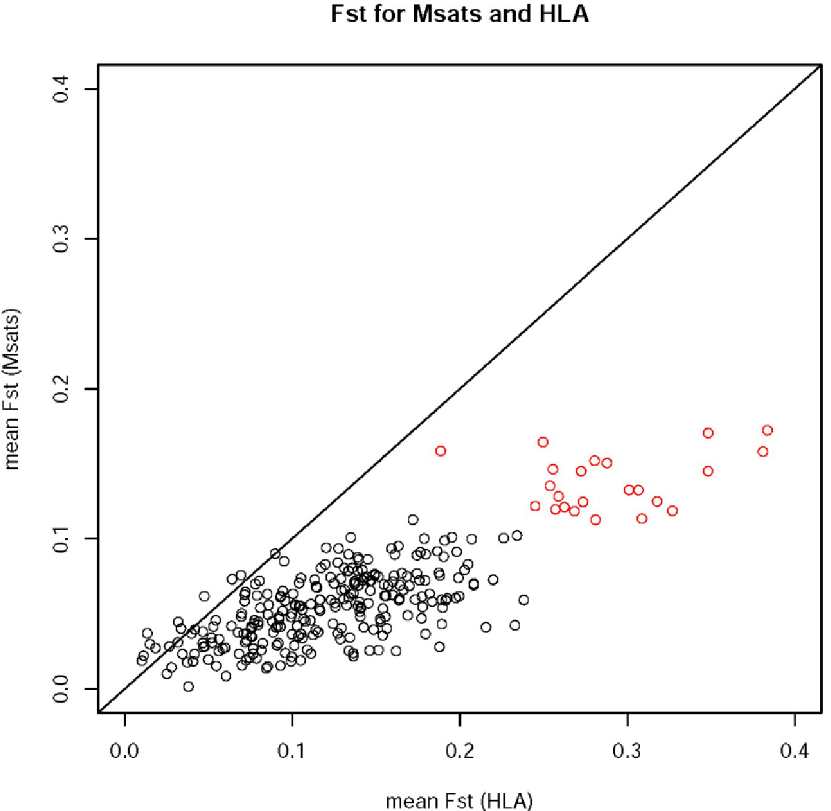
Fig 6. F ST for population pairs at HLA and microsatellites. F ST values were computed for each population pair and locus. F values were summarized over the microsatellite and HLA loci separately. Results are shown for ST microsatellites in the highest (third) quartile of heterozygosity. Pairs involving the Ache are in red since this population has been excluded from other analyses due to their outlier